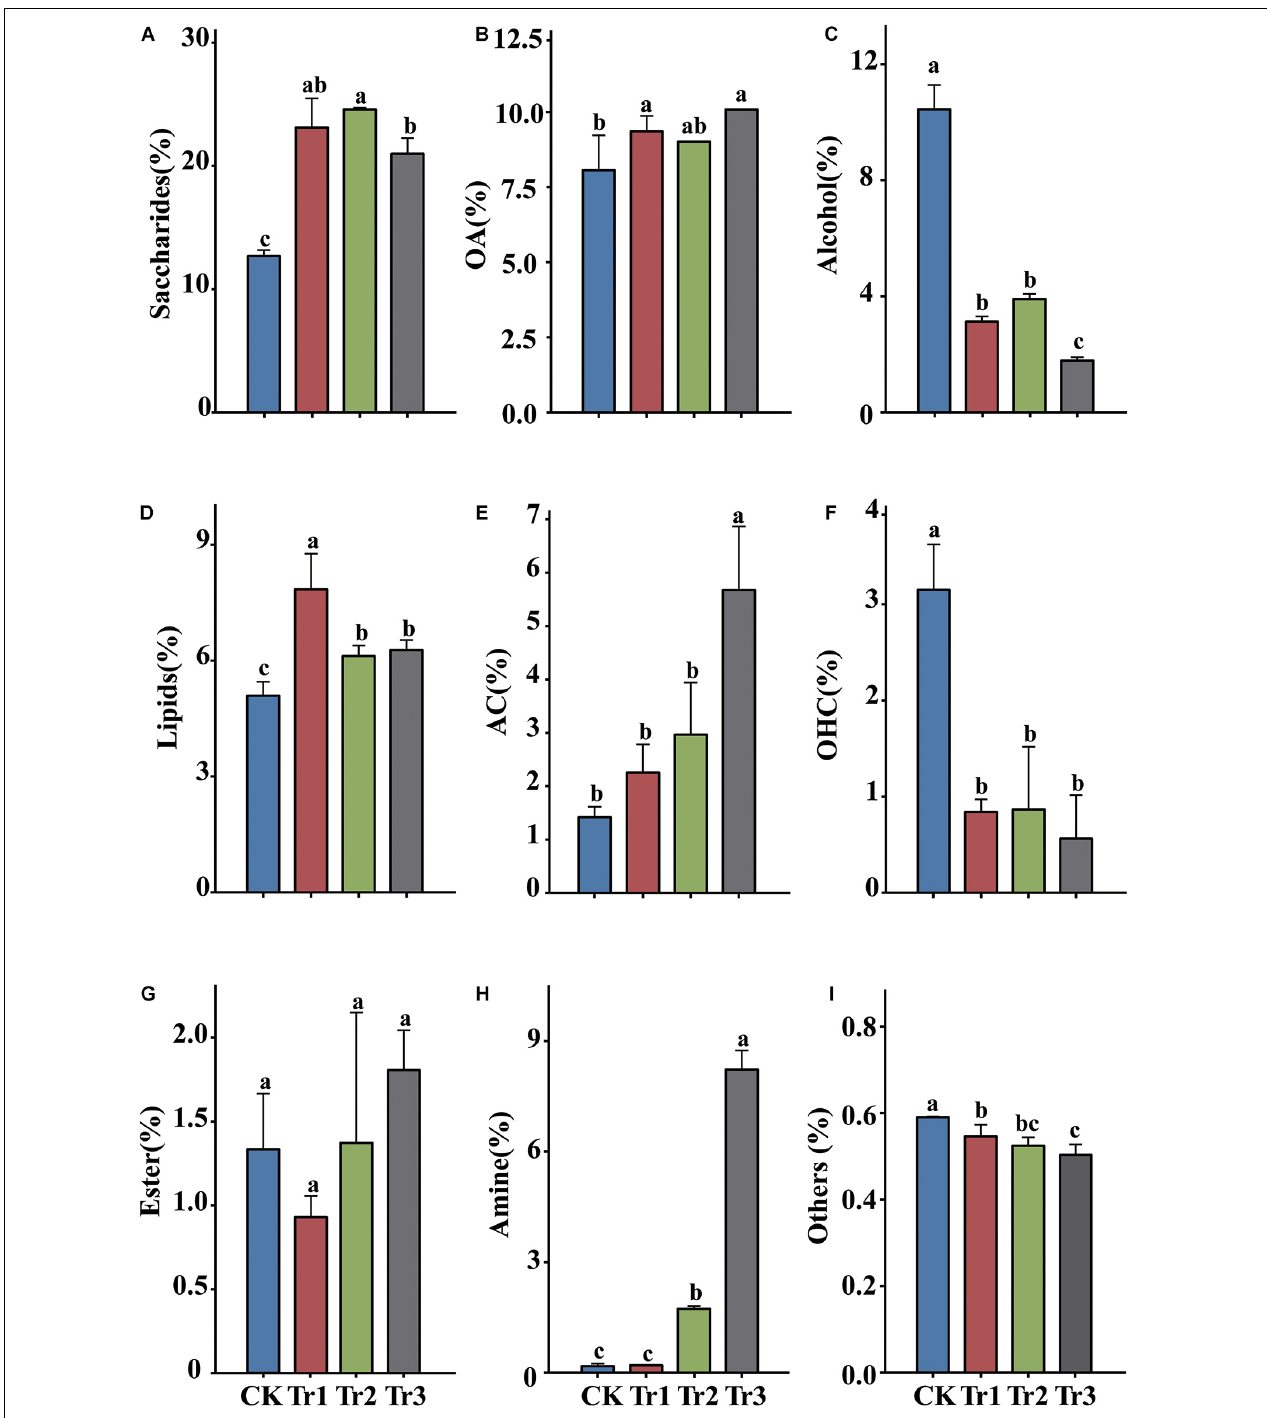
FIGURE 1 | The relative contents of the main root exudate components in rhizosphere soil in intercropping treatments with different species of aromatic plants. (A) Saccharides, (B) organic acids (OA), (C) alcohol, (D) lipids, (E) aromatic compounds (AC), (F) organic heterocyclic compounds (OHC), (G) esters, (H) amine, and (I) others. Values are the mean ± SD ( n = 3). Different letters indicate significant differences at P < 0.05 based on Duncan’s multiple range test.